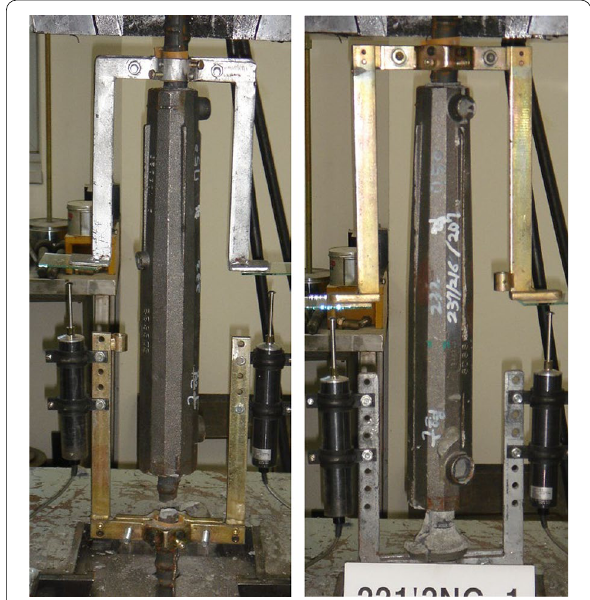
Fig. 2 Final failure pattern. (Bar fracture and bond